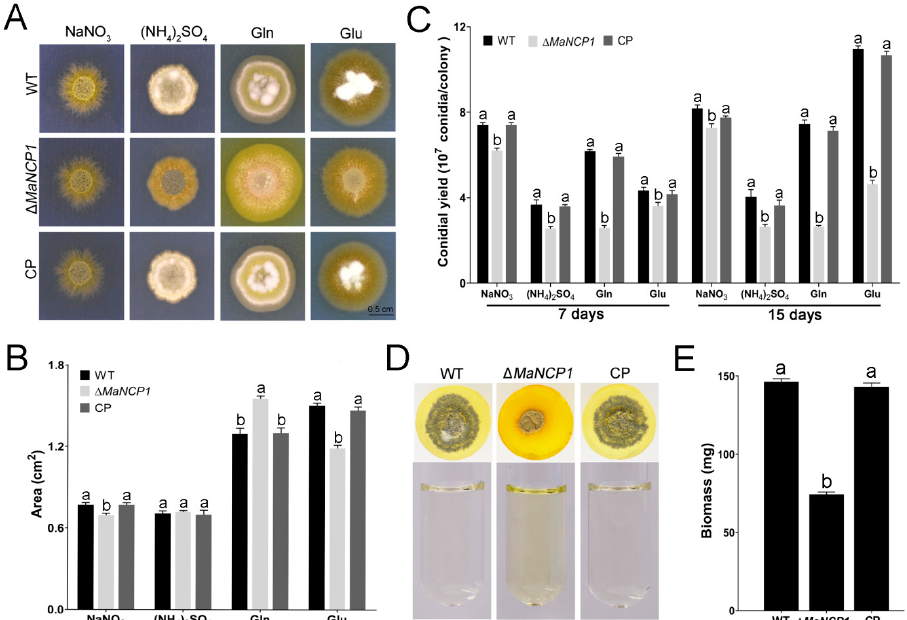
Figure 2. MaNCP1 affects the nitrate assimilation. Colony morphology ( A ) and colony areas ( B ) of the fungal strains grown on the modified CZA medium at 28 °C for 7 days. The concentration of all nitrogen sources was 10 mM. ( C ) Conidial yield of each strain grown on the modified CZA medium and cultured for 7 or 15 d, respectively. ( D ) Colony morphology of each strain cultured in the 24-well plates for 7 d ( Top ), and fermentation liquor of the fungal strains inoculated in CZB (CZA without agar) with 220 rpm for 48 h ( Bottom ). Gln (10 mM) was acted as the sole nitrogen source in CZB liquid medium. ( E ) Biomass of the liquid fermentation for 48 h. Gln, Glutamine. Glu, Glutamate. Lowercase letters indicate significant difference at p < 0.05 (Tukey’s HSD at the same treatment and the letters indicate a comparison between strains cultivated on the same modified CZA.